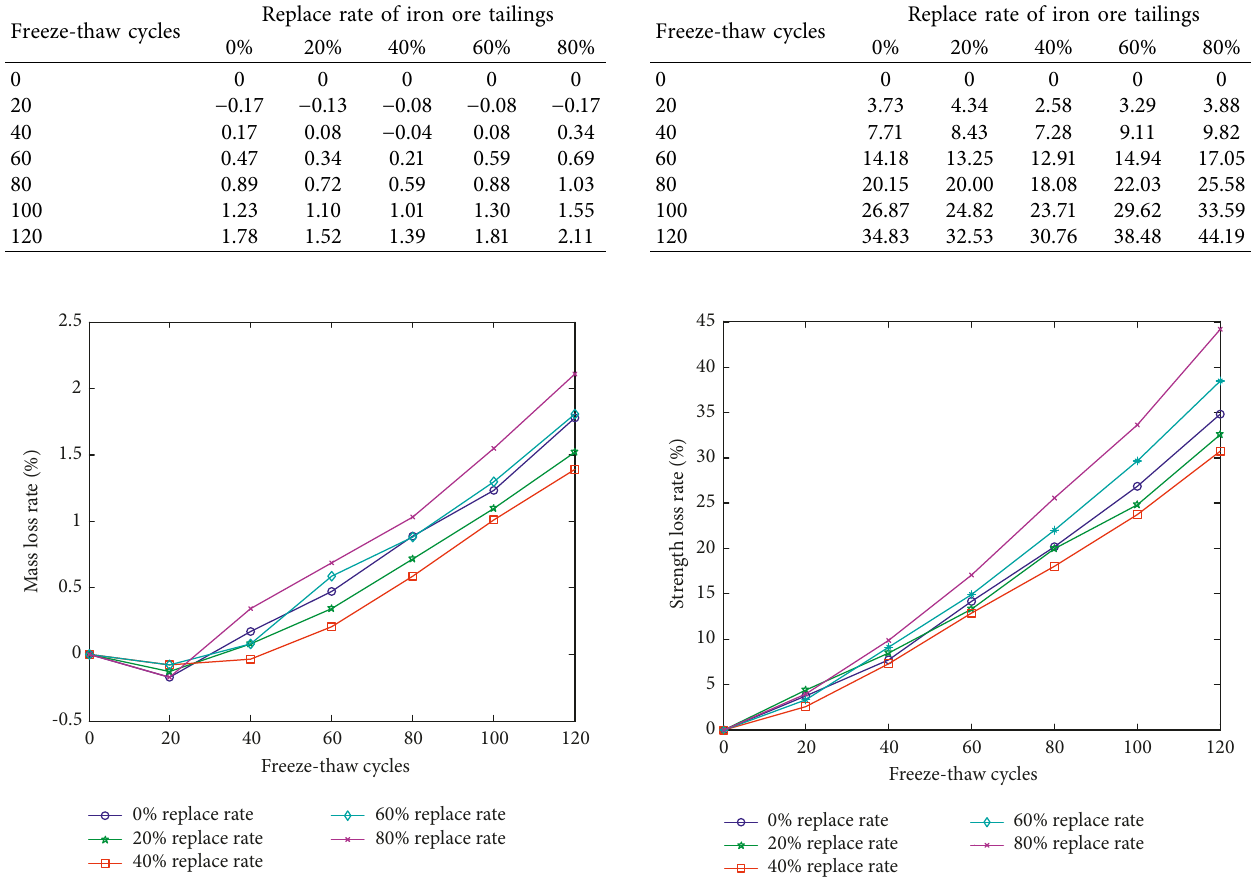
Figure 3: The relationship between mass loss rate and freeze-thaw cycles.